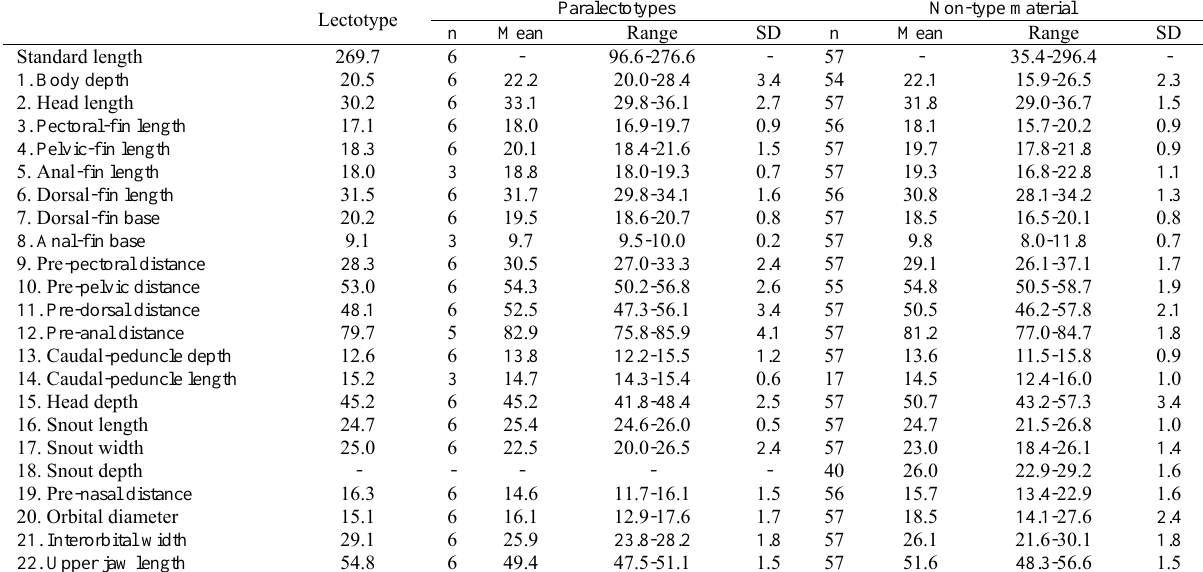
Table 1. Morphometric data of Hoplias microlepis . Standard length in mm; values 1-14 are percentages of the standard length and values 15-22 are percentages of head length. n = number of examined specimens, SD = standard